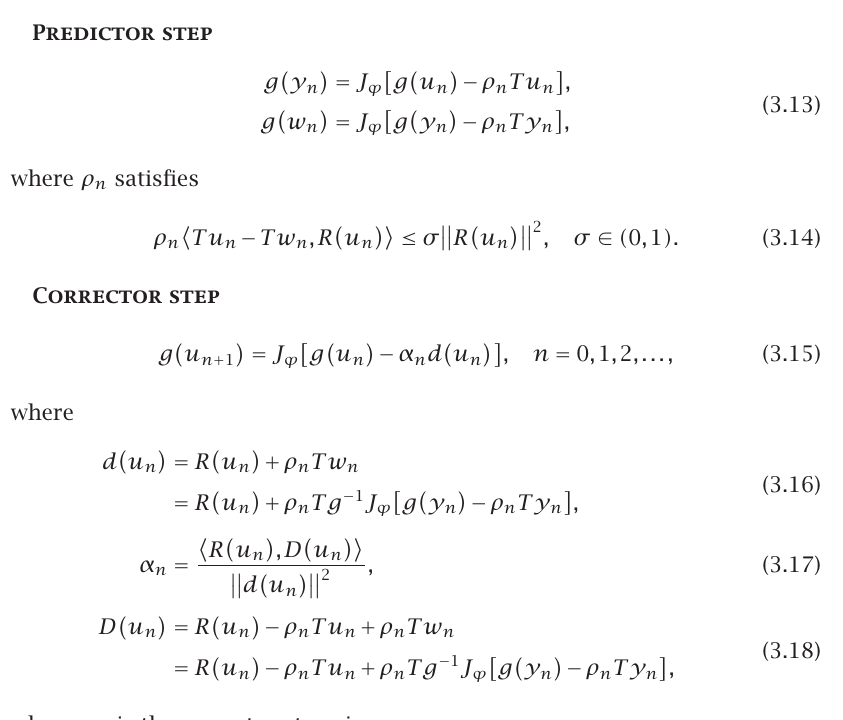
Algorithm 3.5 . For a given u u n + 1 by the following iterative